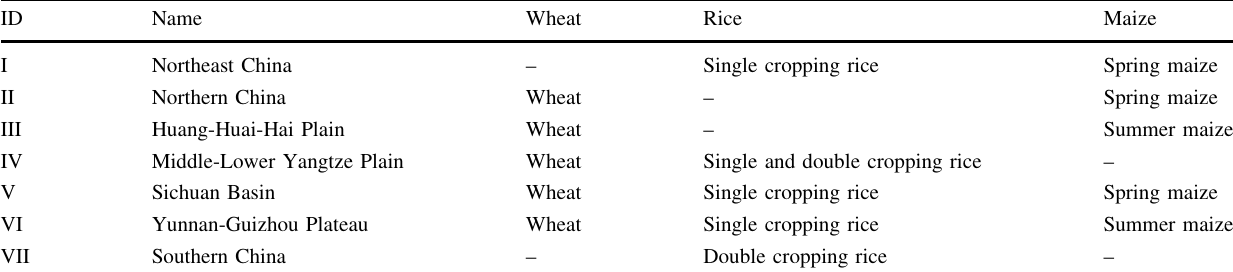
Table 1 Main agricultural zones of three crops in China